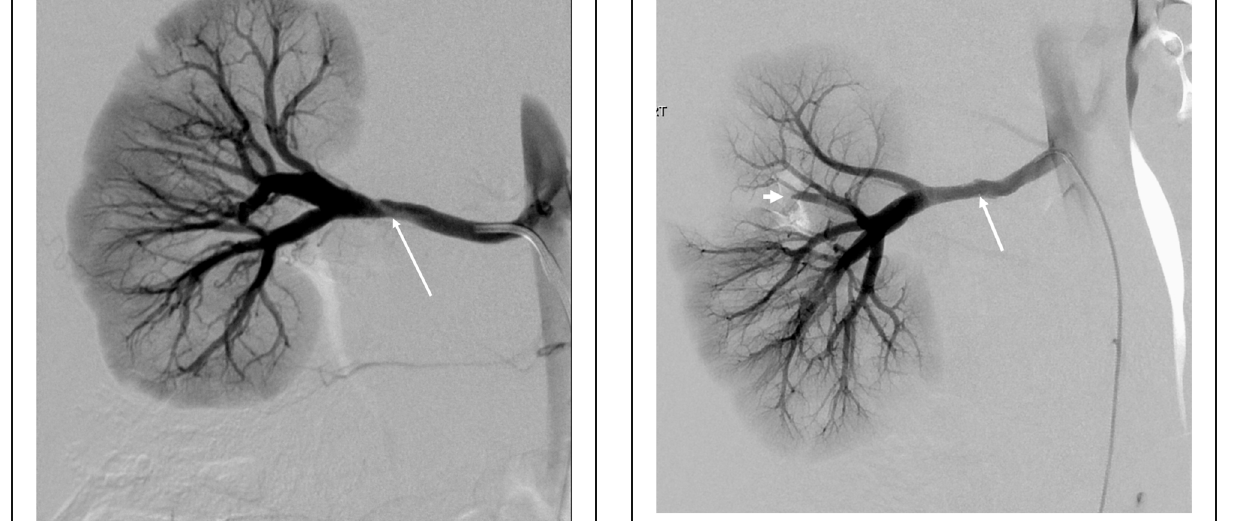
Fig. 5 Non-flow limiting dissection. Angiography right renal artery demonstrating a lucent dissection flap with normal distal renal perfusion consistent with a non-flow limiting dissection (arrow)